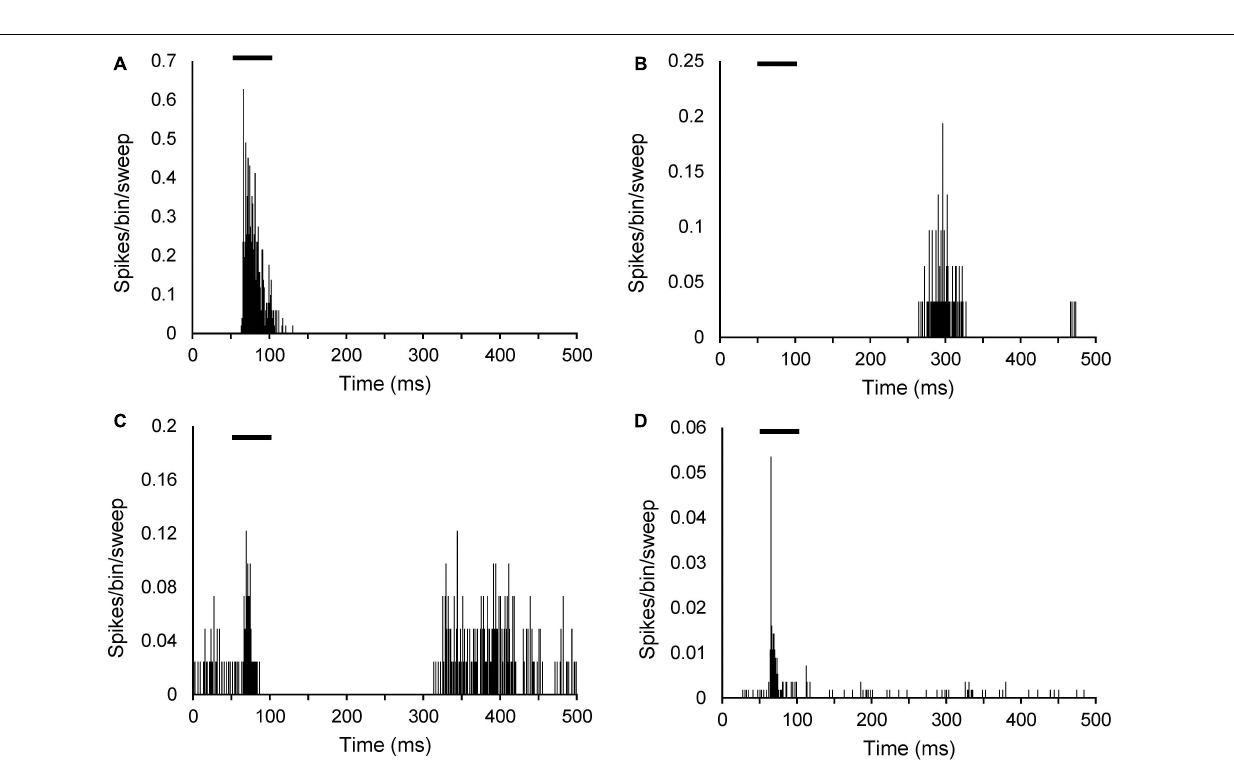
Frontiers in Synaptic Neuroscience |